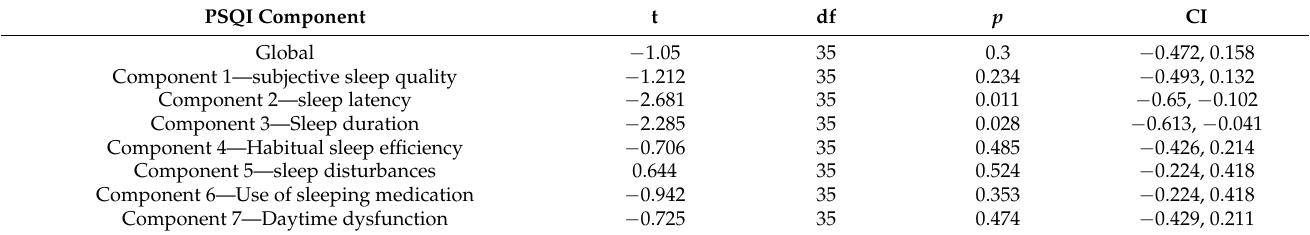
Table 2. Point–biserial correlations between magnesium hair concentration and PSQI